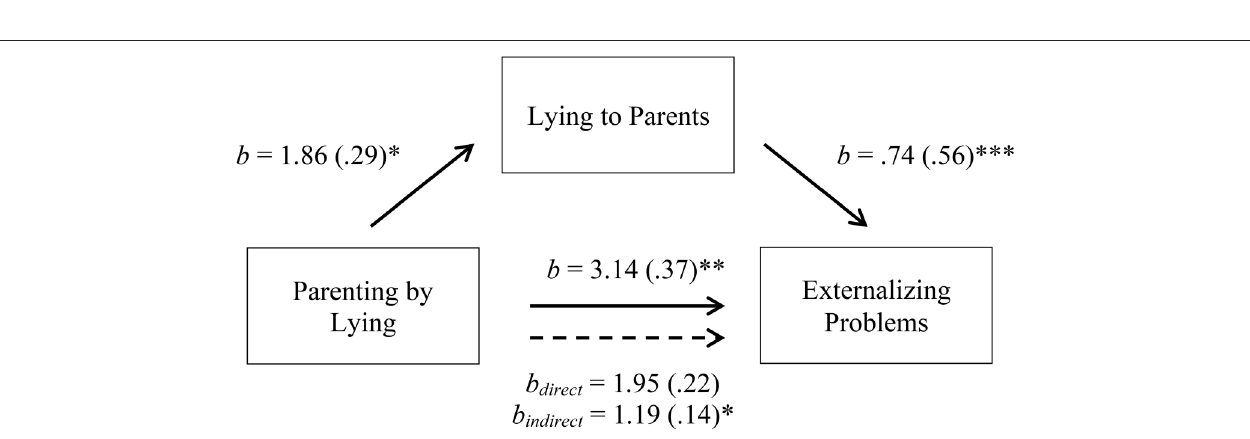
FIGURE 3 | Indirect-only mediation model between parenting by lying and externalizing problems. The solid lines represent the simple linear regressions (paths a, b, and c); the dotted line represents the bootstrapped direct and indirect effects of X on Y after controlling for M. Bracketed values indicate the standardized Beta